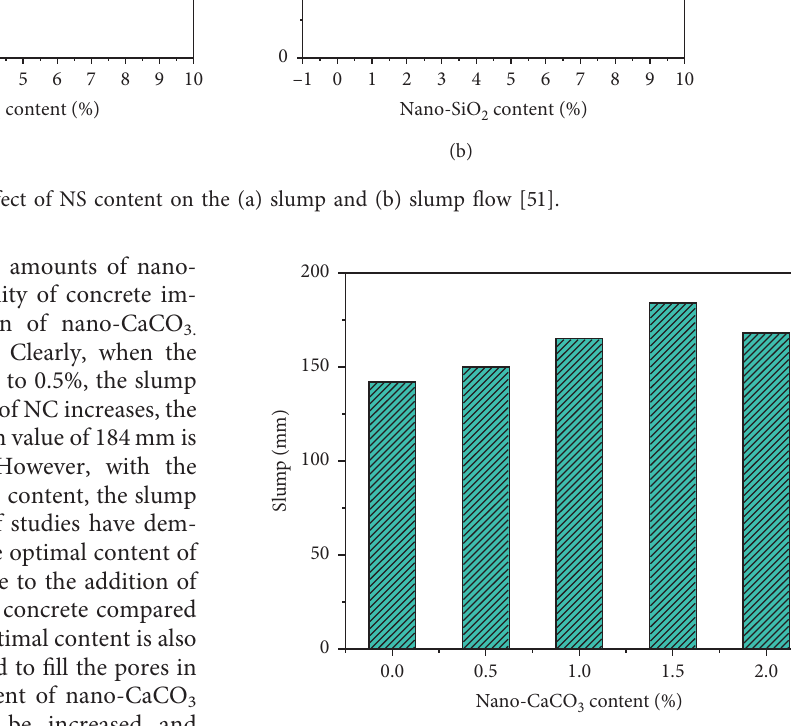
Figure 4: Relationship between the slump and NC content